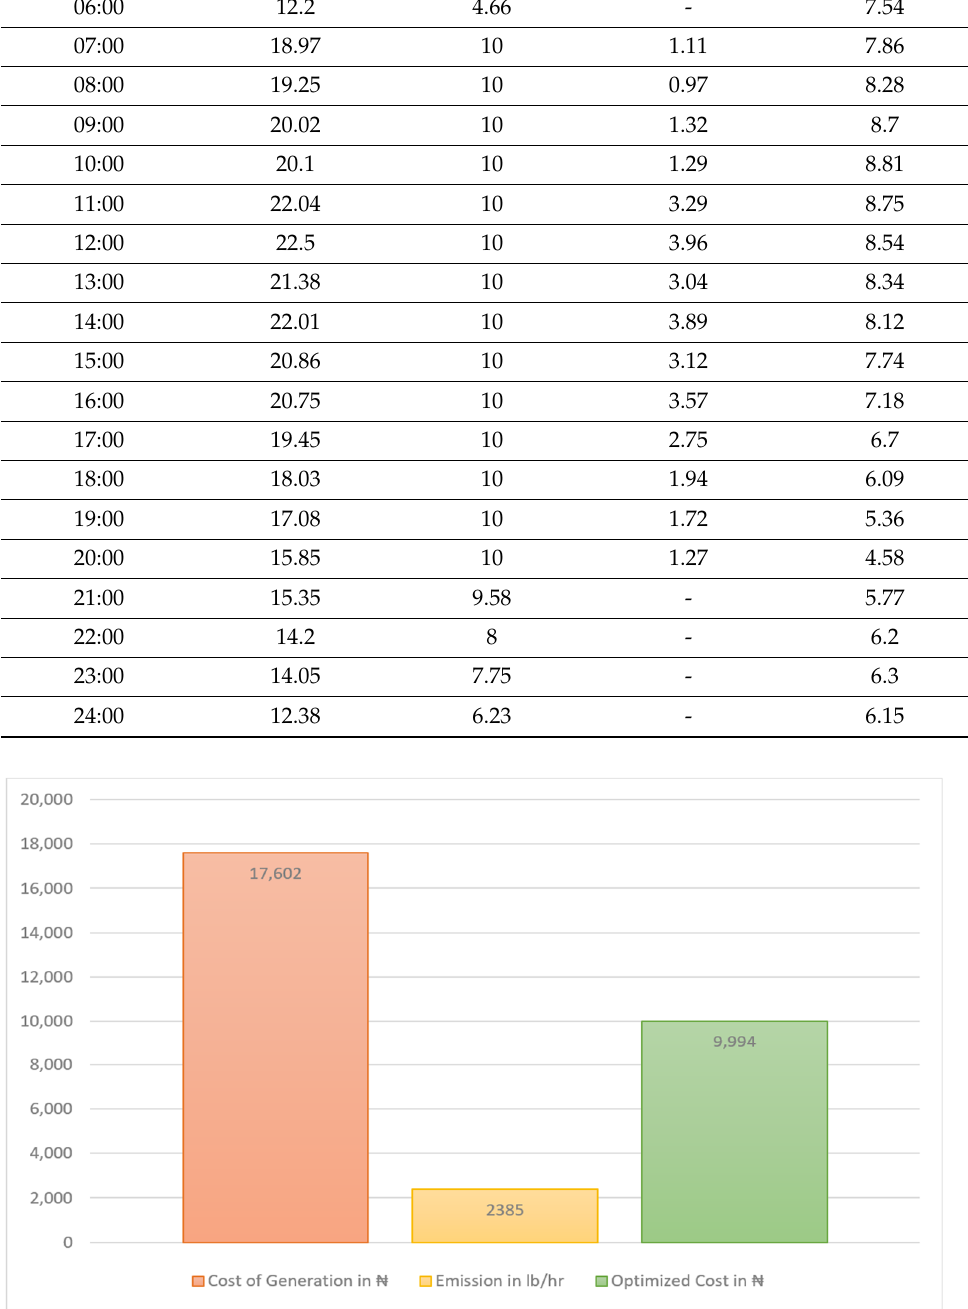
Figure 6. Case 2: Performance evaluation of economics and emissions.